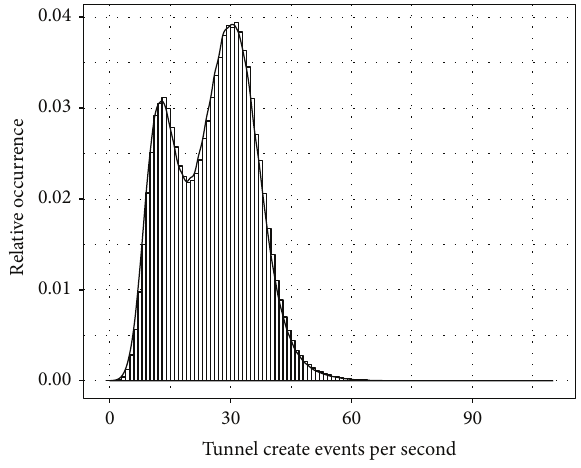
Figure 6: Tunnel arrivals in one second intervals.